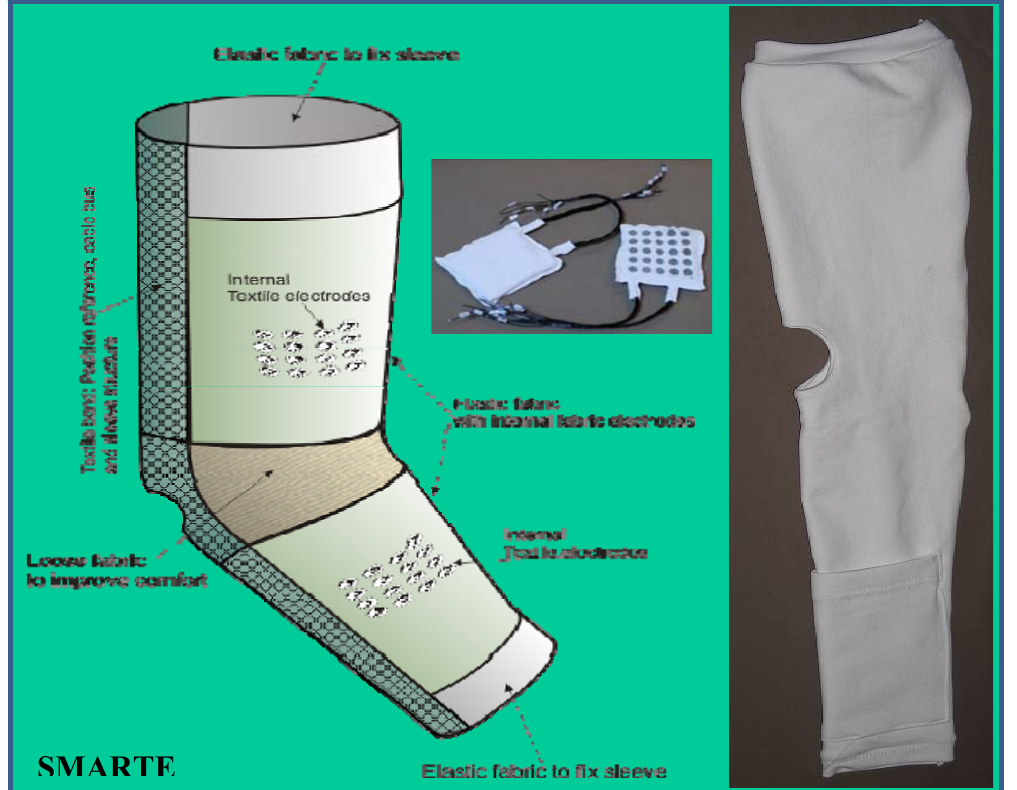
Figure 5. Illustration of a textile with a matrix of surface EMG electrodes used to record upper limb tremor. The textile is designed to fit with comfort issues. Courtesy of Smartex,